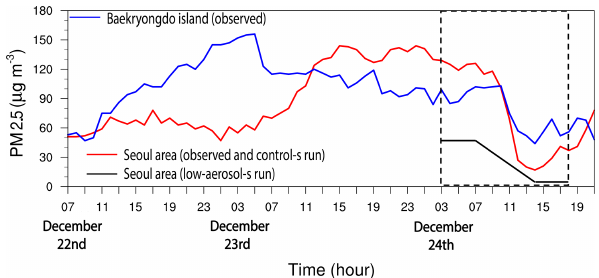
Figure 2. Time series of PM 2 . 5 observed at the ground station in Baekryongdo island (blue line) and of the average PM 2 . 5 over ground stations in the Seoul area (red line) between 07:00LST on 22 December and 21:00LST on 24 December 2017. Note that PM 2 . 5 observed at stations in the Seoul area is applied to the control-s run whose period is marked by the dashed rectangle. Time series of the average PM 2 . 5 over stations in the Seoul area in the low-aerosol-s run for the simulation period is also shown (solid black